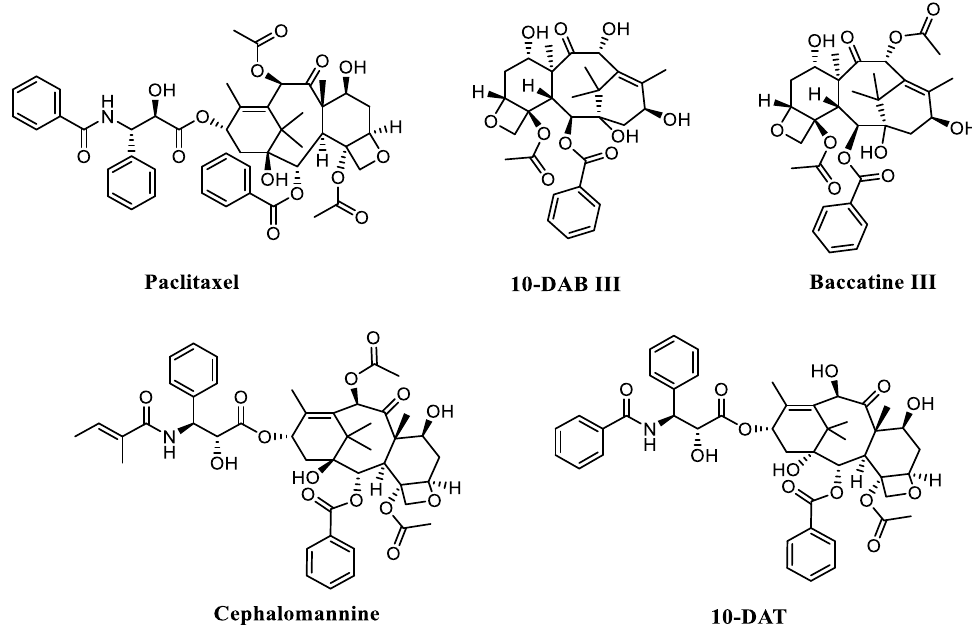
Figure 1. Chemical structures of five taxanes.